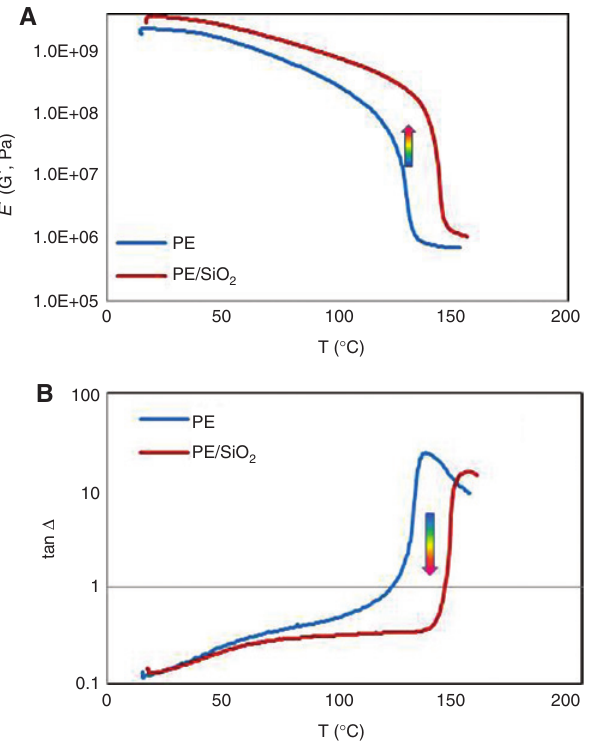
gel composites along 2